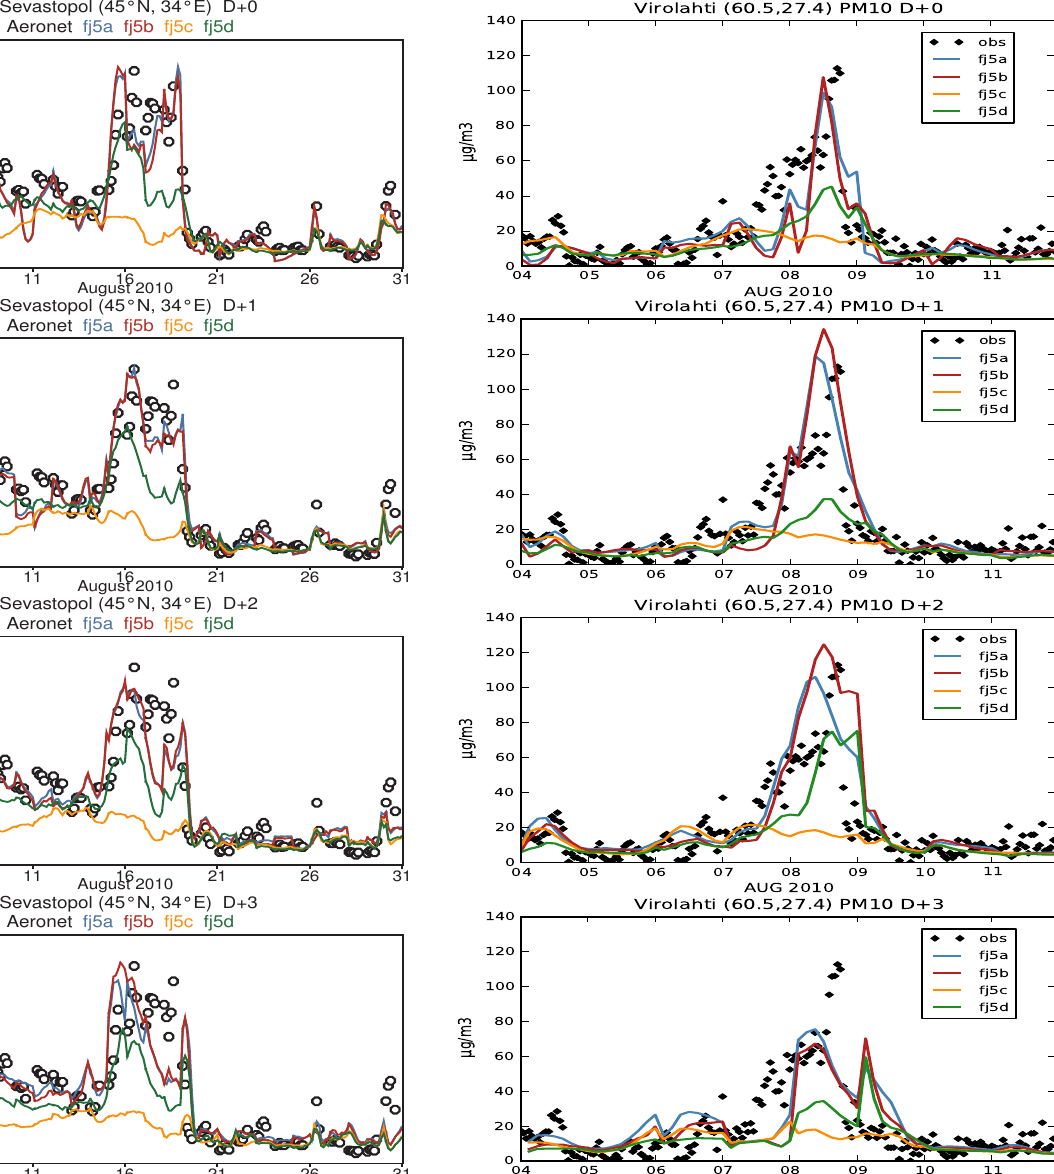
Fig. 13. In-situ observations of PM 10 and hindcasts of atmospheric aerosol concentrations [µgm − 3 ] near the surface in Virolahti, Fin- land for 4–11August 2010. Hindcasts with lead times of 3–24h (D+0), 27–48h (D+1), 51–72h (D+2) and 75–96h (D+3). Clima- tological analysis in blue (fj5a), NRT analysis in red (fj5b), clima- tological model in yellow (fj5c), NRT model in green (fj5d). (ob- servations courtesy Finnish Meteorological Institute)